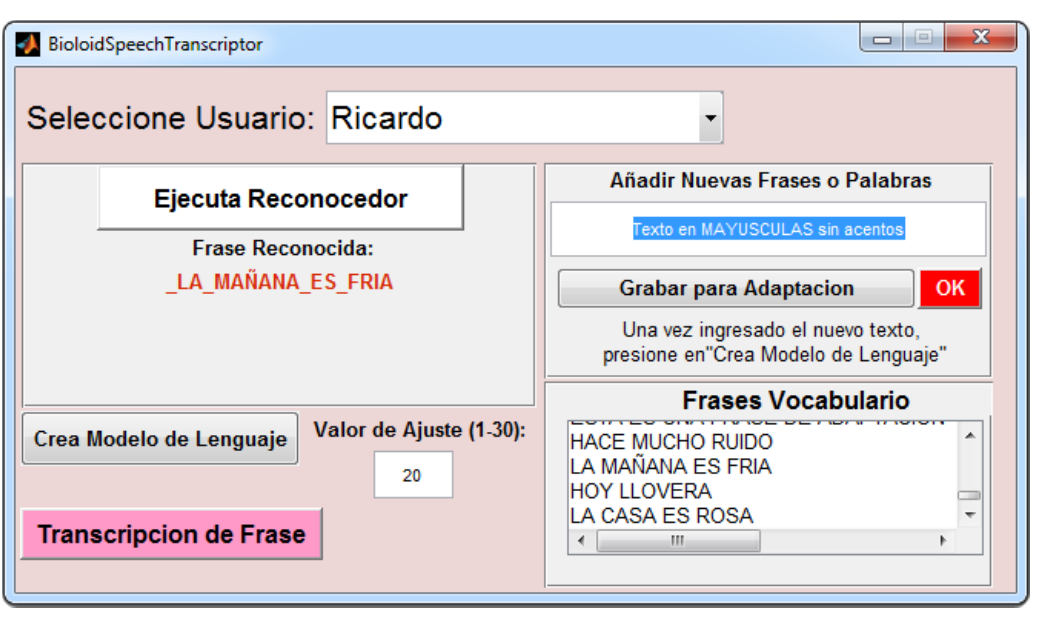
Figure 5. Speech recognition interface of the speech-to-text